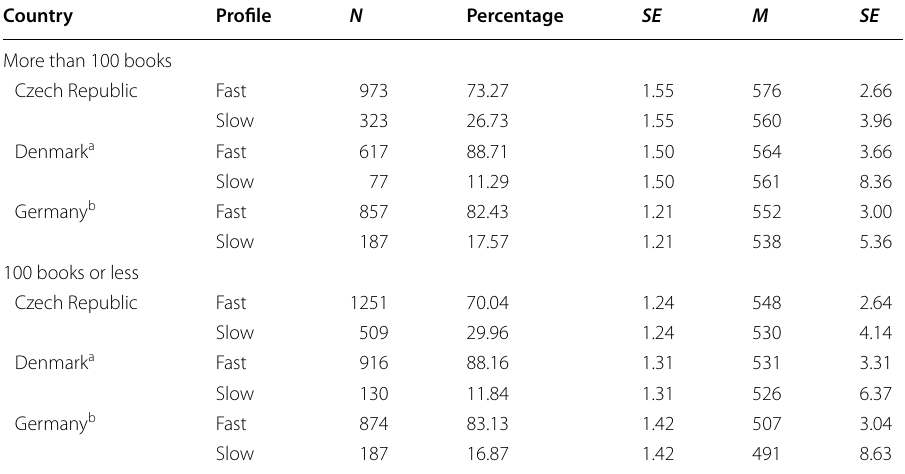
Table 5 Processing profiles, computer and information literacy (CIL) and cultural capital